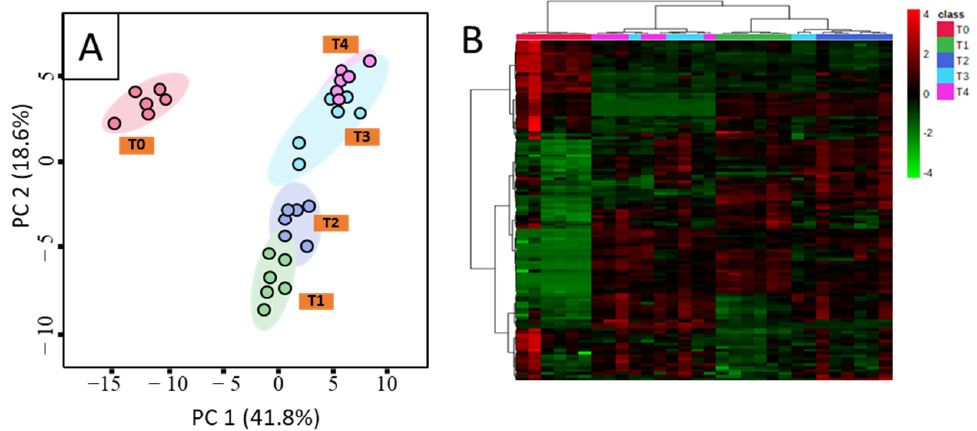
Figure 3. PCA score plot ( A ) and heatmap ( B ) of metabolites in young tea shoots under recommended amount of nitrogen (N), phosphorus (P), and potassium (K) application (T1), high P application (T2), high K application (T3), high P and K application (T4), and control (T0) treatments analyzed by gas chromatography-mass spectrometry (GC-MS). Note: The horizontal scale of heatmap ( B ) represents the different fertilization treatment groups, and the vertical scale represents the differential metabolites. Color from green to red represents the expression abundance of metabolites from low to high.